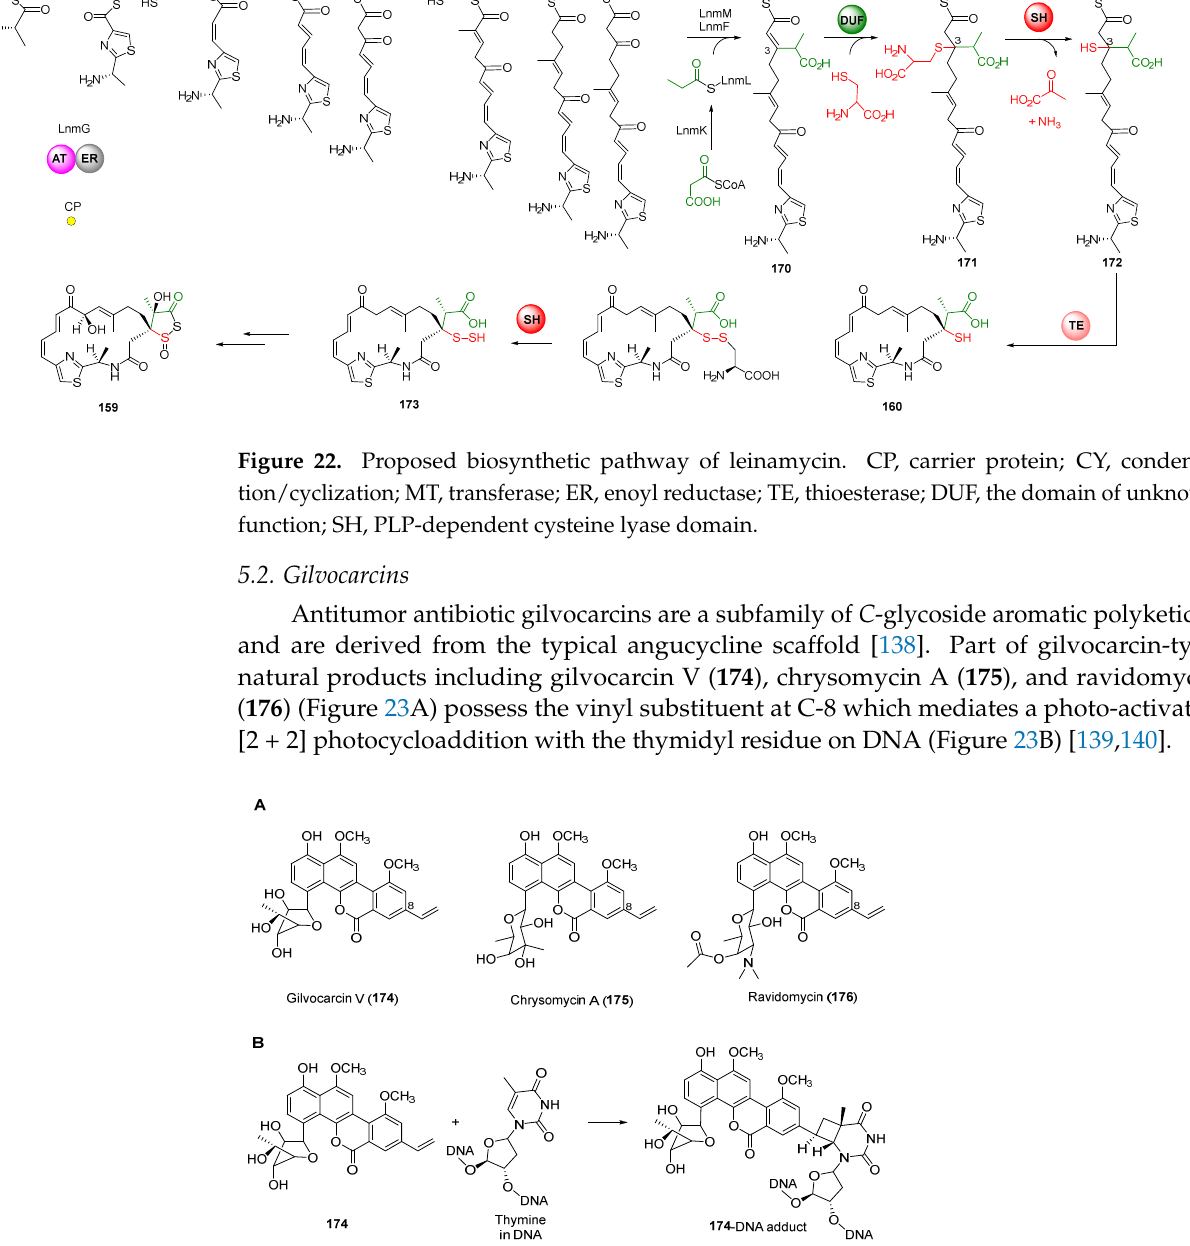
Figure 22. Proposed biosynthetic pathway of leinamycin. CP, carrier protein; CY, condensation/cy-